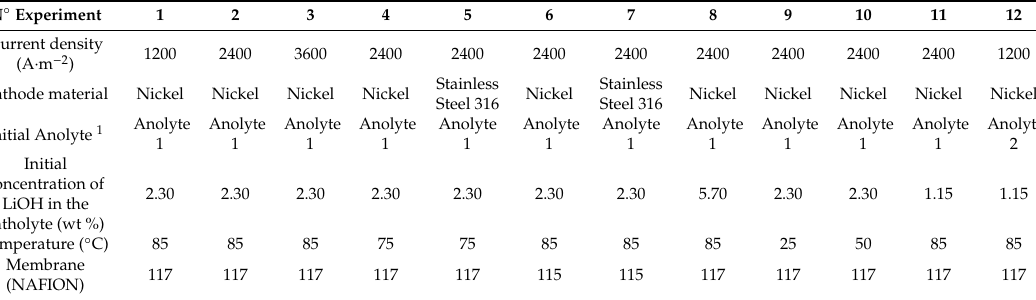
Table 2. Operating conditions for each